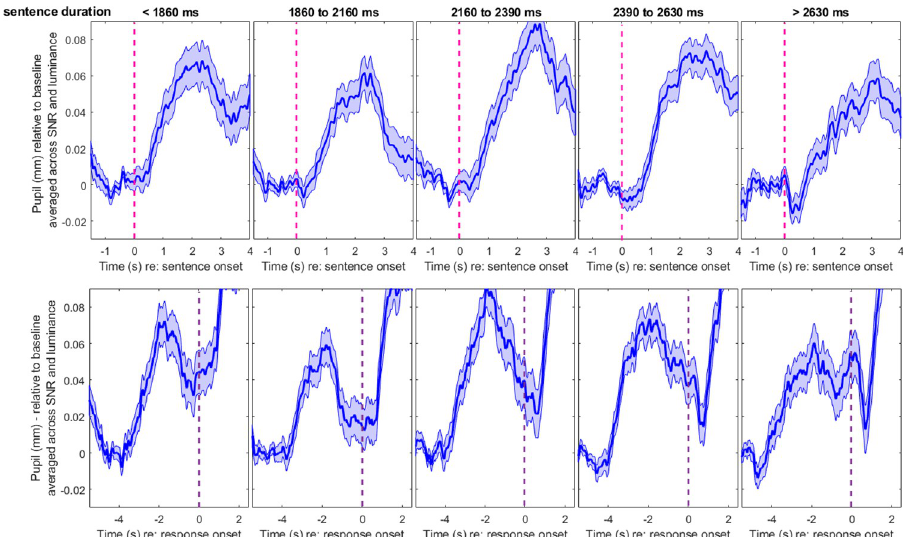
Fig 7. Pupil metrics across different sentence durations in Experiment 2. Baseline-corrected pupil traces measured in Exp.2 across different duration bins, aligned from the sentence onset (top) or from the response prompt (bottom). Longer sentences elicited larger PPDs, and whether this was accompanied by later PPDs depended on time alignment: The delayed PPD with longer stimuli is largely compensated for when sentences are aligned by their offset. Shaded area represented 1 standard error from the